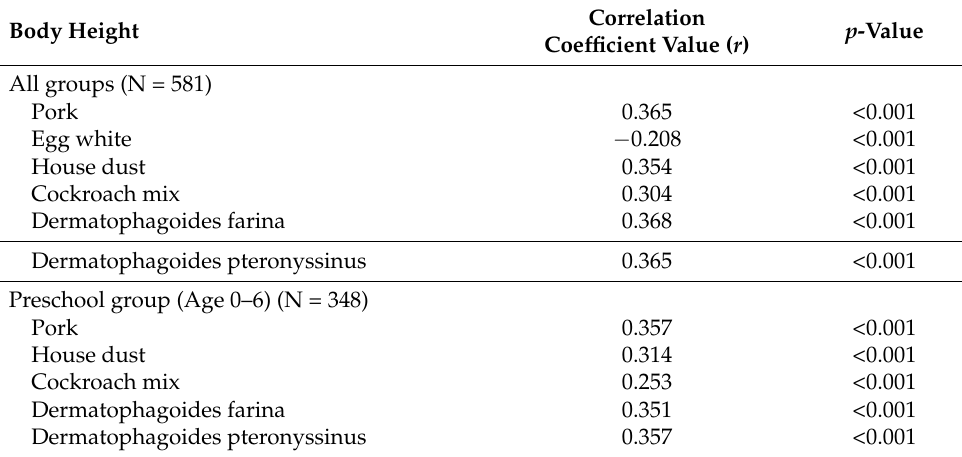
Table 3. The associations between body height and allergen-specific